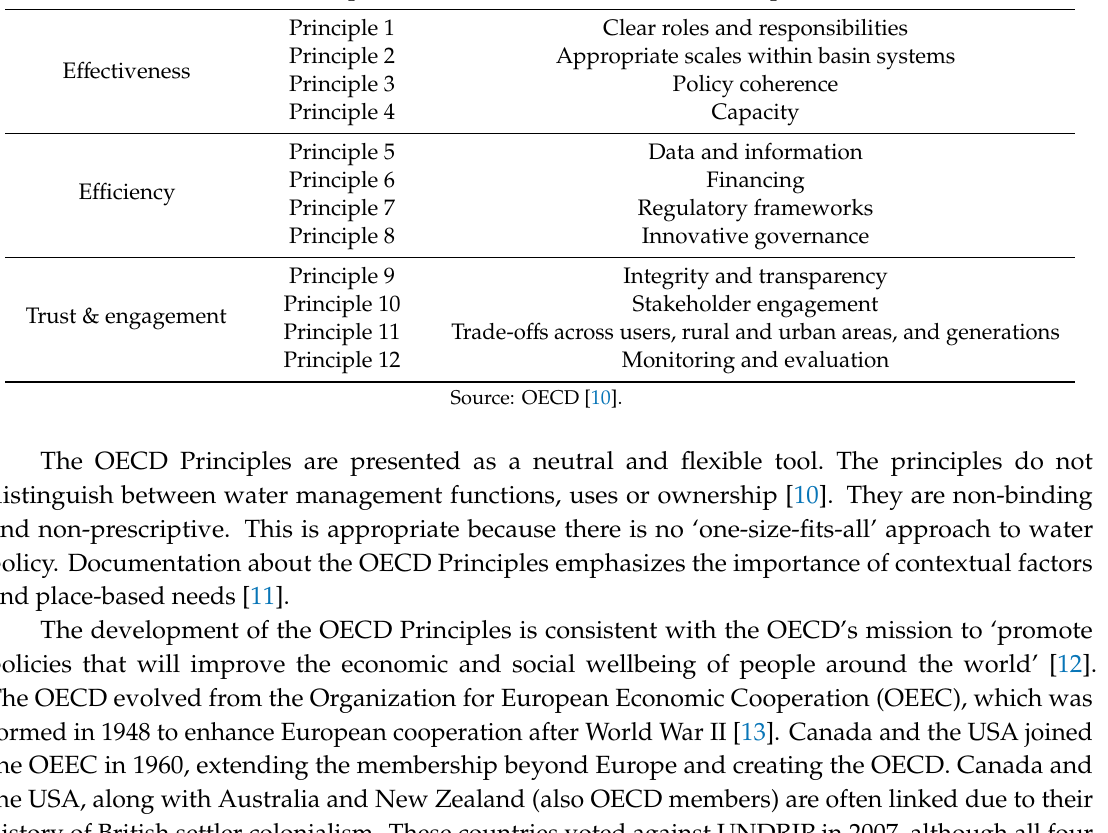
Table 1. The 3 dimensions of the OECD 12 Principles on Water Governance. Dimension Principle # Principle Principle 1 Clear roles and responsibilities Principle 2 Appropriate scales within basin systems E ff ectiveness Principle 3 Policy coherence Principle 4 Capacity Principle 5 Data and information Principle 6 Financing E ffi ciency Principle 7 Regulatory frameworks Principle 8 Innovative governance